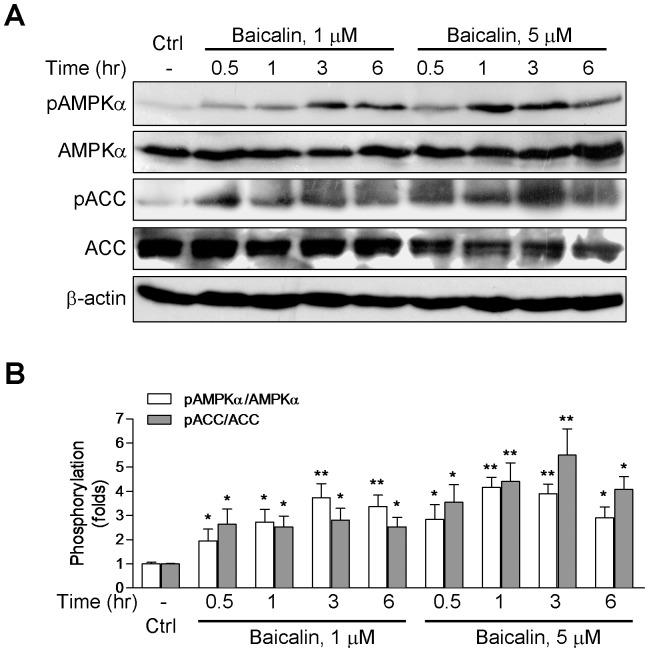
Baicalin increases the phosphorylation of AMPKα and ACC in A549 cells.(A) Representative Western blots for the phosphorylation of AMPKα at Thr-172 (pAMPKα) and the phosphorylation of ACC at Ser-79 (pACC) after treatment with baicalin for the indicated times. (B) Histogram represents the fold change in the pAMPKα/AMPKα or pACC/ACC ratio from at least three independent experiments. * p<0.05 and ** p<0.01 compared to respective control.